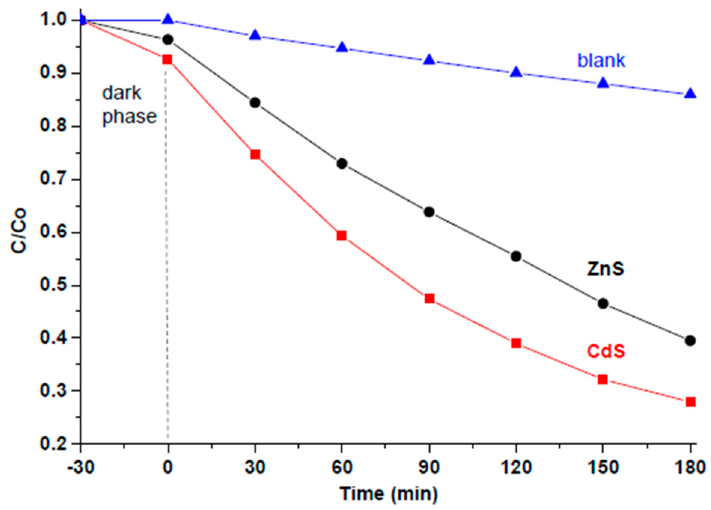
Figure 5. Photocatalytic activity of CdS and ZnS towards MB degradation in aqueous solution. Decay of MB caused by ZnS (red) and CdS (black line) is clearly observed over time.